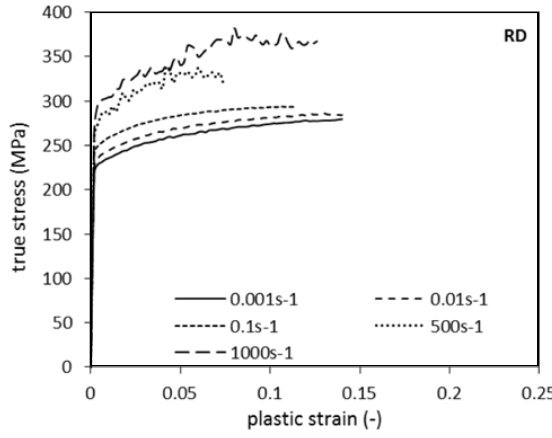
Fig. 11. E ff ect of strain rate on the flow curves of ZEK100 sheet in the RD.